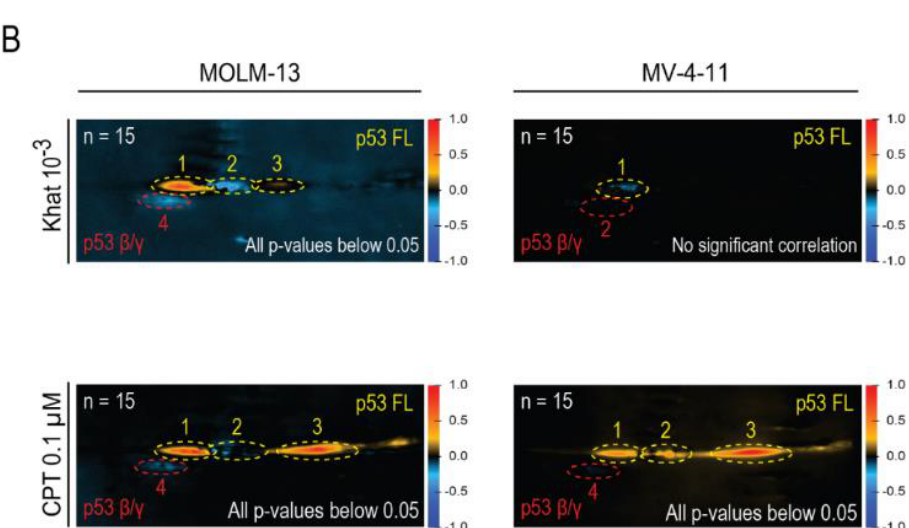
Figure 2. Khat induced post-translational modifications (PTMs) and altered p53 isoform patterns. ( A ) MOLM-13 and MV-4-11 were exposed to a khat-extract dilution of 10 – 3 and 0.1 μM CPT for 1 and 4 h, and analyzed for alterations in p53 isoform patterns using two-dimensional polyacrylamide gel electrophoresis (2D-PAGE) and Western blotting (original blots can be found at Figure S2). ( B ) Three